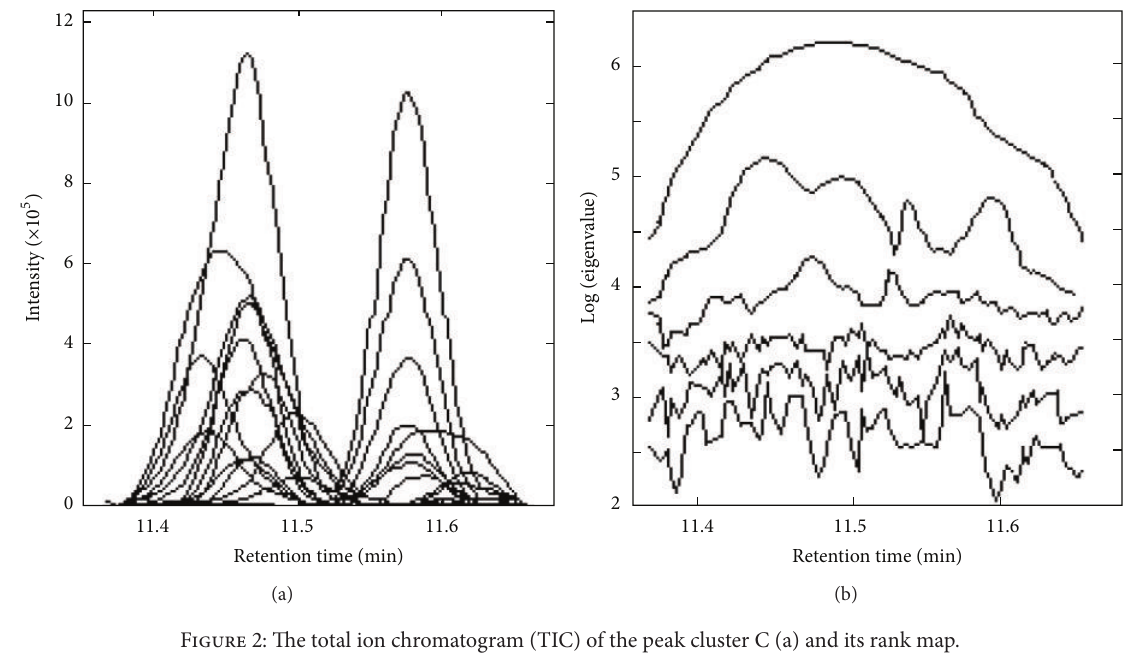
Figure 2: The total ion chromatogram (TIC) of the peak cluster C (a) and its rank map.